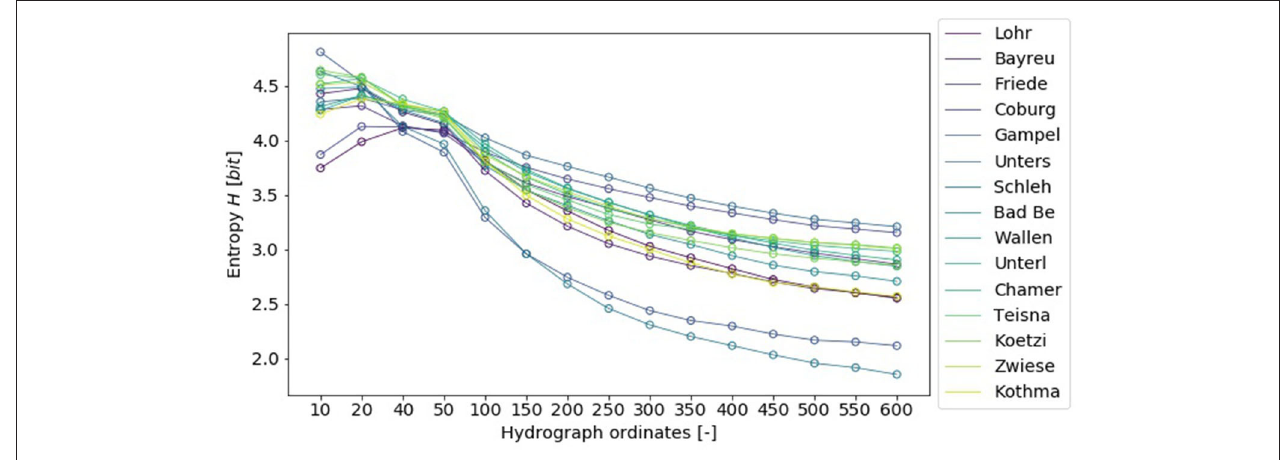
FIGURE 3 | Entropy values of the data sets H considering a varying number of ordinates from hydrographs (number of ordinates considered on the